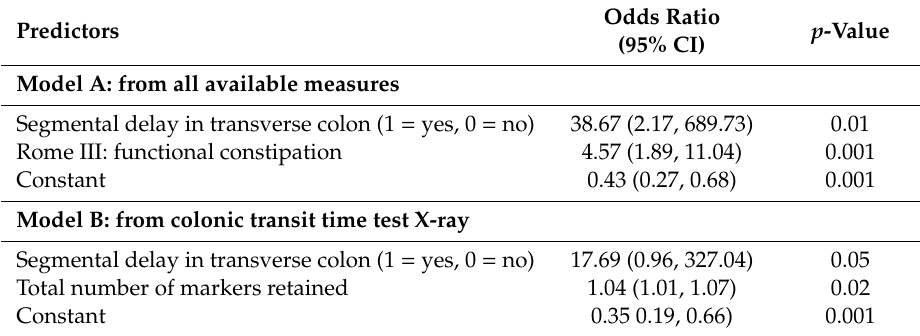
Table 4. Models for predicting PD status from bowel function.